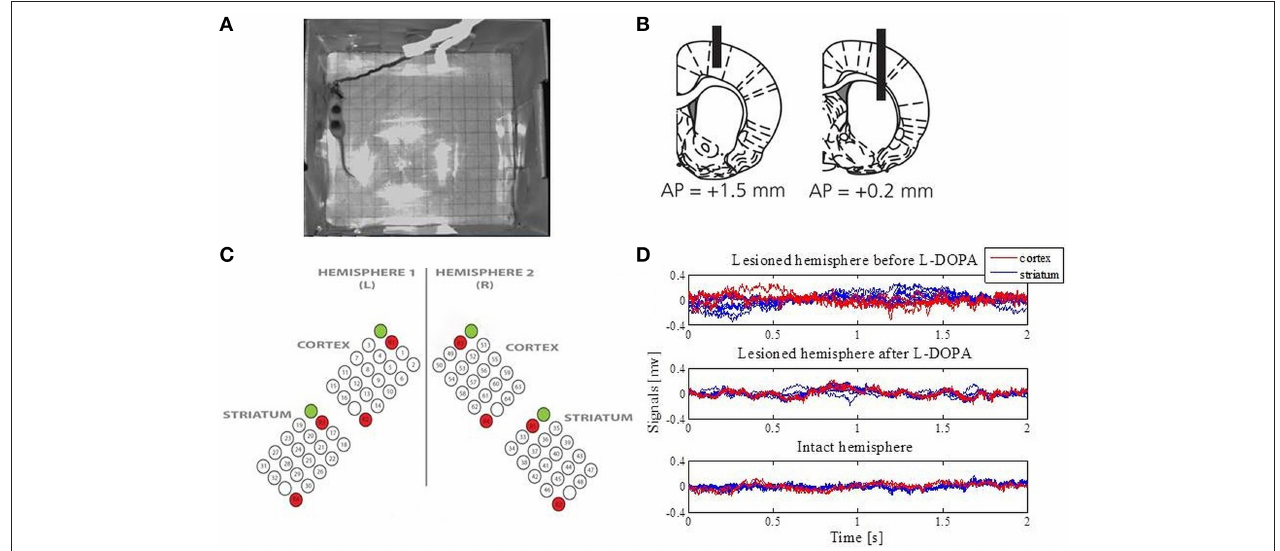
FIGURE 1 | Data acquisition. (A) An example of the open-field recordings. (B) Schematic illustration of the positioning of electrodes relative to the bregma (modified from Halje et al., 2012). Coronal plane indicating vertical positions for the cortex (the left panel) and the striatum (the right panel) together with AP positions. Electrodes were implanted bilaterally. (C) The electrodes were arranged over four structures: the left primary motor cortex, the right primary motor cortex, the left sensorimotor striatum and the right sensorimotor striatum. Each array consisted of 16 recording channels, two reference channels (marked in red) and one stimulation channel (marked in green and not used in this study). (D) Extracted LFPs from the intact and lesioned hemisphere that represent one epoch for a duration of